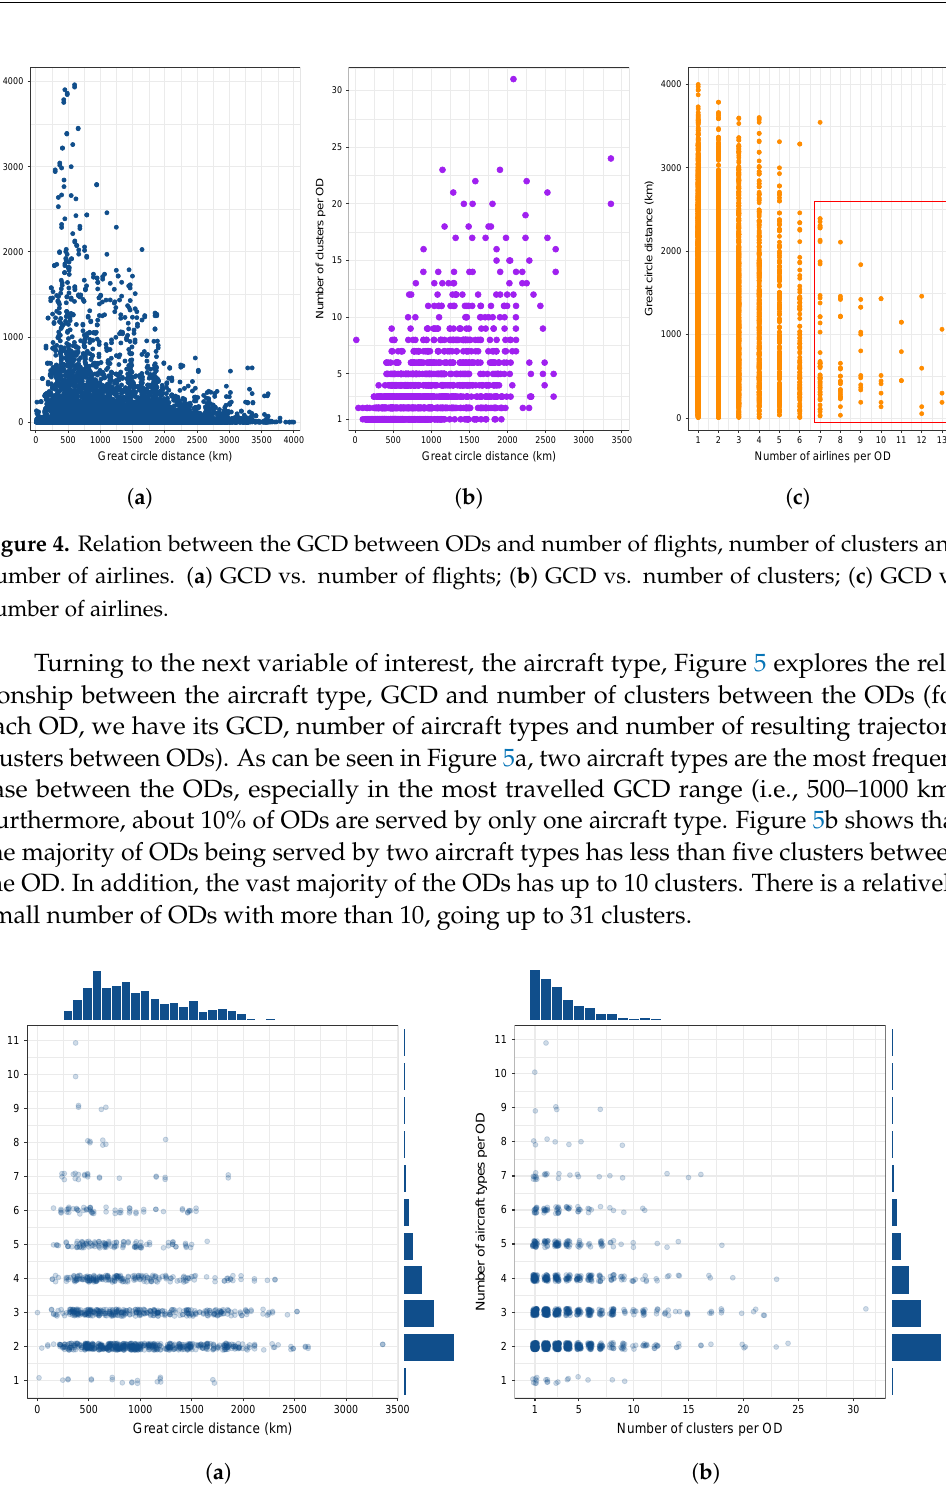
Figure 5. Relations between the aircraft type, clusters and GCD. ( a ) Aircraft type vs. GCD length; ( b ) Aircraft type vs. trajectory